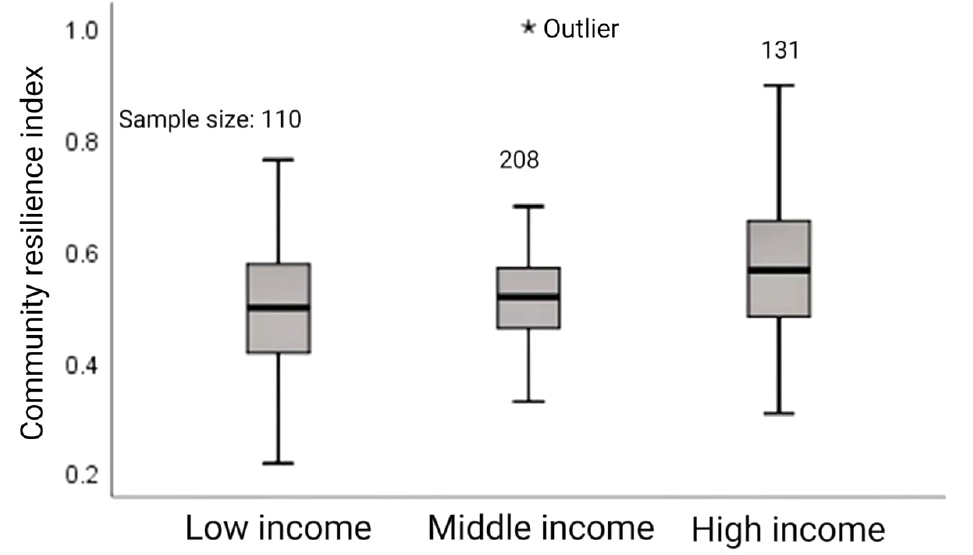
Figure 6. Community resilience index of relocated households at different income levels. The median of the resilience index of the relocated community from the village was inclined to the upper part of the box body, and the cut-off point of the upper part was close to the box body, presenting a high concentration distribution. The median of the community resilience index of relocated households from neighboring villages is located in the lower part of the box, and the lower truncation point is close to the box, showing a low concentrated distribution. On the whole, the community resilience index of relocated households from the village is higher than that of neighboring village relocation house- holds, which indicates that the closer the distance of village-level relocation, the higher the community resilience index. The median community resilience index of relocated households from neighboring towns is the highest and skewed to the upper quartile. The community resilience index of relocated households from other places is evenly distributed (see Figure 7).